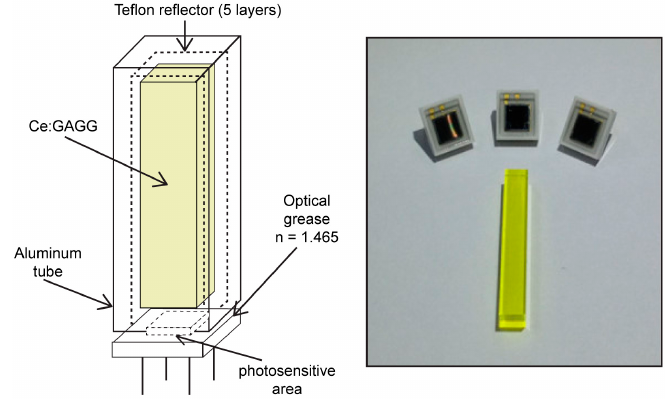
Figure 1. Structure of Ce-doped Gd–Al–Ga–garnet (Ce:GAGG) detector head ( left ); 3 × 3 mm 2 Hamamatsu S12572-100C SiPM and 3 × 3 × 20 mm 3 Ce:GAGG crystal ( right ).